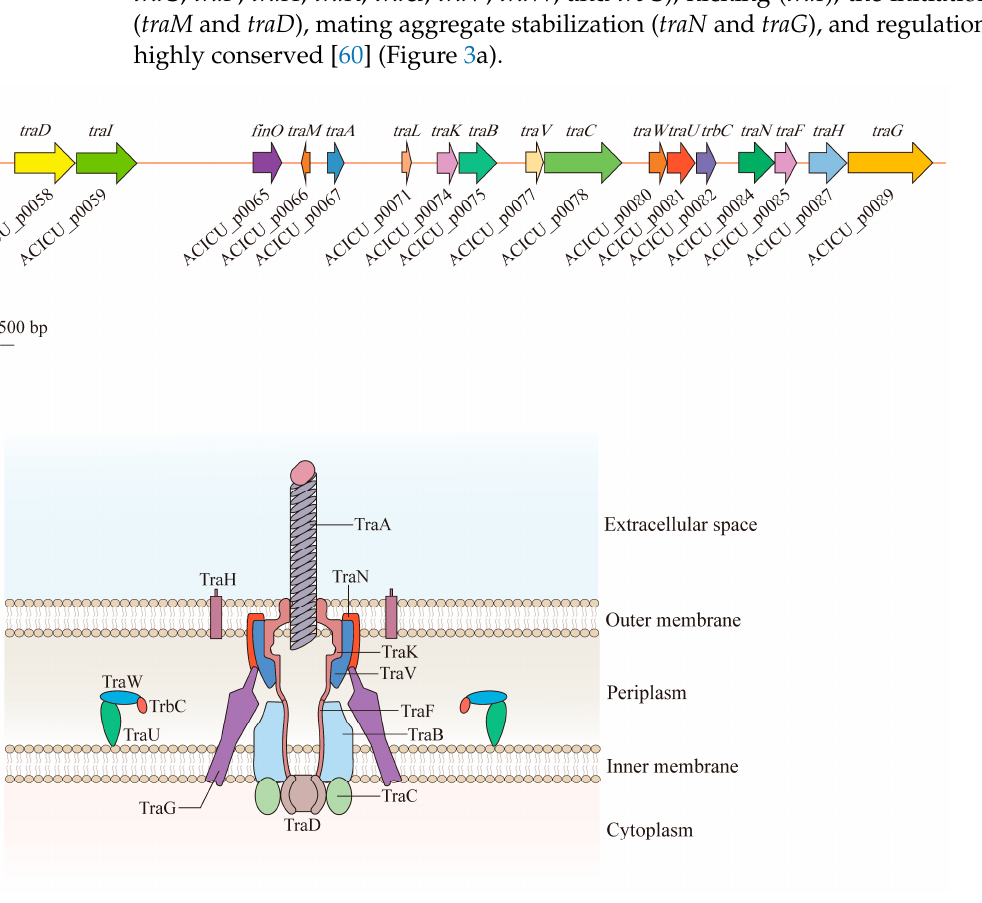
Figure 3. Structural organization of the type IV secretion system (T4SS) in A. baumannii : ( a ) Discovered in the A. baumannii ACICU plasmid pACICU2, the F-type T4SS contains a series of tra operon genes, and two other genes, trbC and finO . ( b ) The T4SS is a highly sophisticated nanomachine span- ning the entire bacterial cell envelope in A. baumannii . The F-like T4SS apparatus is composed of a pilus assembly component (TraA), a core complex (TraK, TraV, TraN, and TraH) embedded in the outer membrane (OM), an inner membrane (IM) platform (TraF, TraB, TraG, TraU, TraW, and TrbC), and components of the cytoplasm (TraC and TraD). 4.2. Function Although there has not been any empirical evidence demonstrating the function of the T4SS in A. baumannii , it is rational to speculate that it has similar performances to the universal T4SSs in other bacteria, as they share similar structures [60,62]. 4.2.1. DNA Exchange and Antibiotic Resistance Generally speaking, T4SSs are ancestrally related to bacterial conjugation machines, which mediate the transfer of genes and proteins across membranes [61]. T4SSs can rec- ognize DNA substrates and translocate them to recipient bacterial cells by conjugative transfer. In this way, horizontal gene transfer is performed to disseminate mobile genetic elements, such as antibiotic resistance genes, virulence genes, and other fitness traits, to benefit bacteria by enhancing their survival in various environments and promoting the evolution of infectious pathogens [61]. The spreading of antibiotic resistance genes will lead to the rapid development of drug-resistant bacteria and even cause outbreaks of nos- ocomial infections. The conservation of most T4SS genes between A. baumannii and E. coli K-12 indicates that the function of the T4SS could be essential and unique in conjugation- mediated gene transfer [60]. Moreover, instead of connecting with the donor cells, T4SSs can either release naked DNAs to the milieu, or take up DNAs from the extracellular environments, therefore ful- filling the exchange of DNAs with the milieu [62,63].